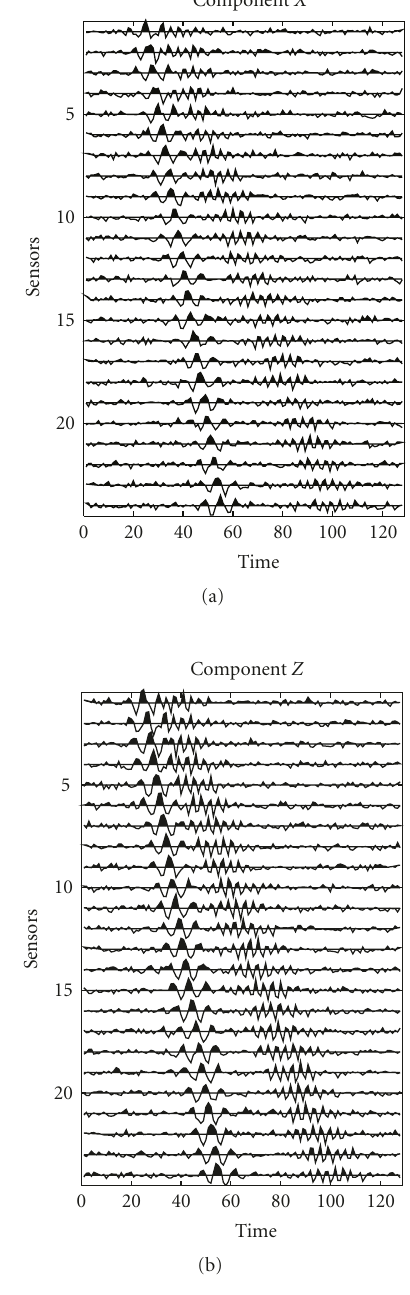
Figure 6: 2-Component initial dataset in time and distance ((a): Horizontal component X , (b): Vertical component Z